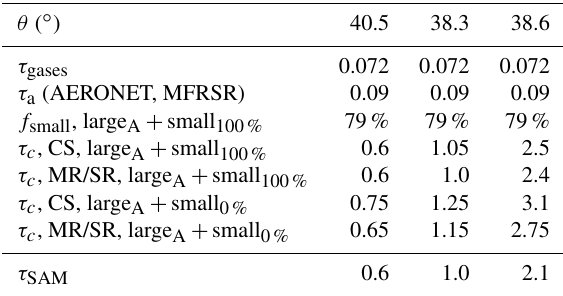
Table 4. The values of solar zenith angle θ and optical thickness of cloud ( τ c ), aerosols ( τ a ), and gases ( τ gases ) used in the com- parison simulations for flight A. The cloud is described with the size-shape distributions large A and large A + small 100% of rough (MR and SR) and completely smooth (CS) ice crystals. The frac- tional contribution of small ice crystals to cloud optical thickness for the large A + small 100% size-shape distribution ( f small ) and the total optical thickness (cloud + aerosols) retrieved from the Sun and Aureole Measurements (SAM) instrument are also listed.